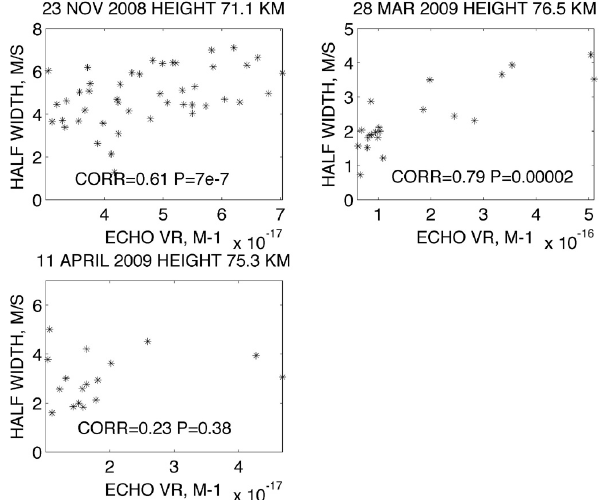
Fig. 8. Profiles of modelled half-power half spectral widths for tur- bulent scatter with different dissipation rates ε shown in the text box. Median spectral widths of LLME for three experiments with (red) and without (blue) correction for maximum beam broadening of 1.7ms − 1 are shown by symbols: o corresponds to 23 Novem- ber 2008; x to 28 March 2009 and * to 11 April